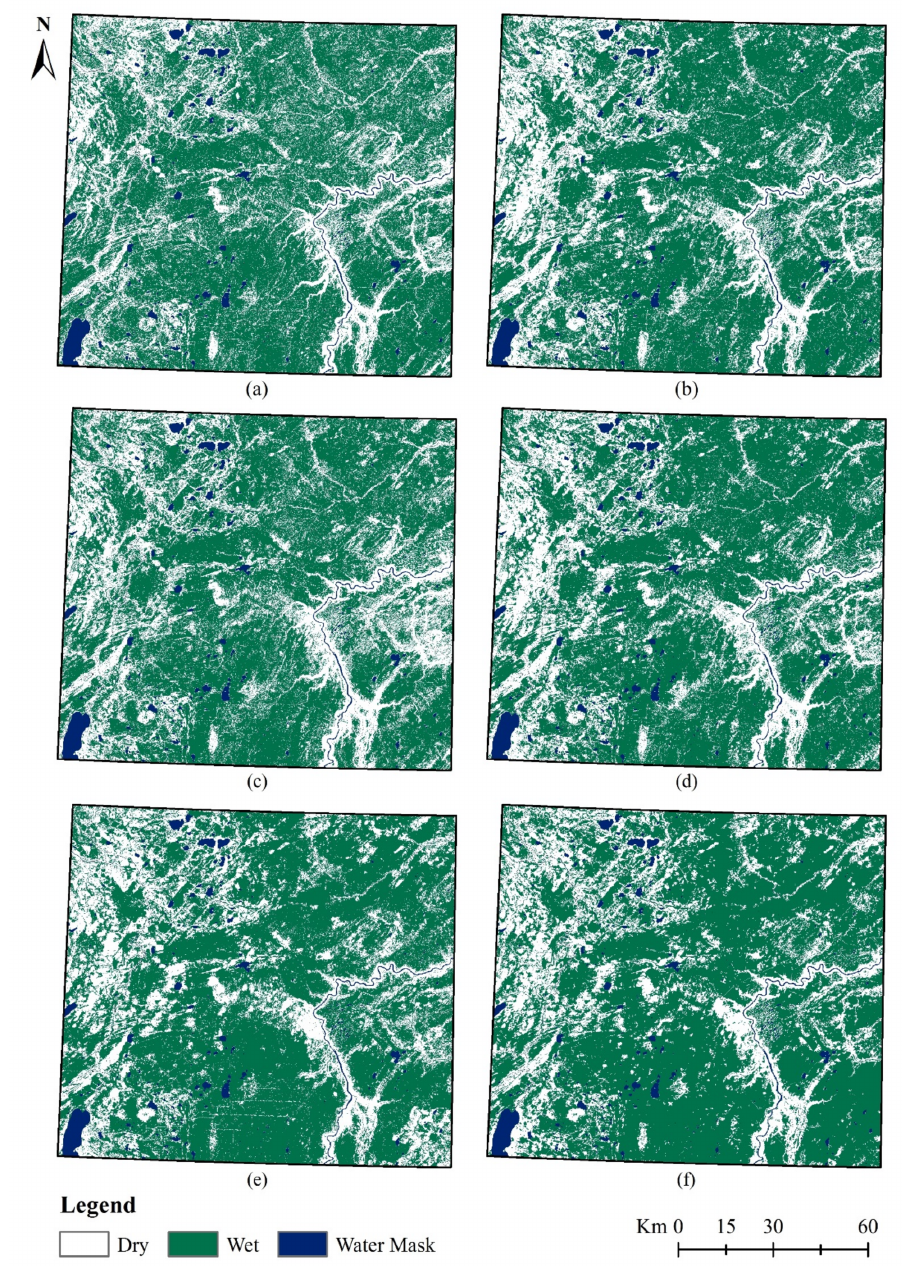
Figure 6. Wet vs. Dry classifications produced by thresholding at a probability of 0.7 models ( a ) T model , ( b ) TO model , ( c ) TS model , and ( d ) TOS model . The ( e ) AMWI and ( f ) reference Alberta Vegetation Inventory (AVIE) data set are also